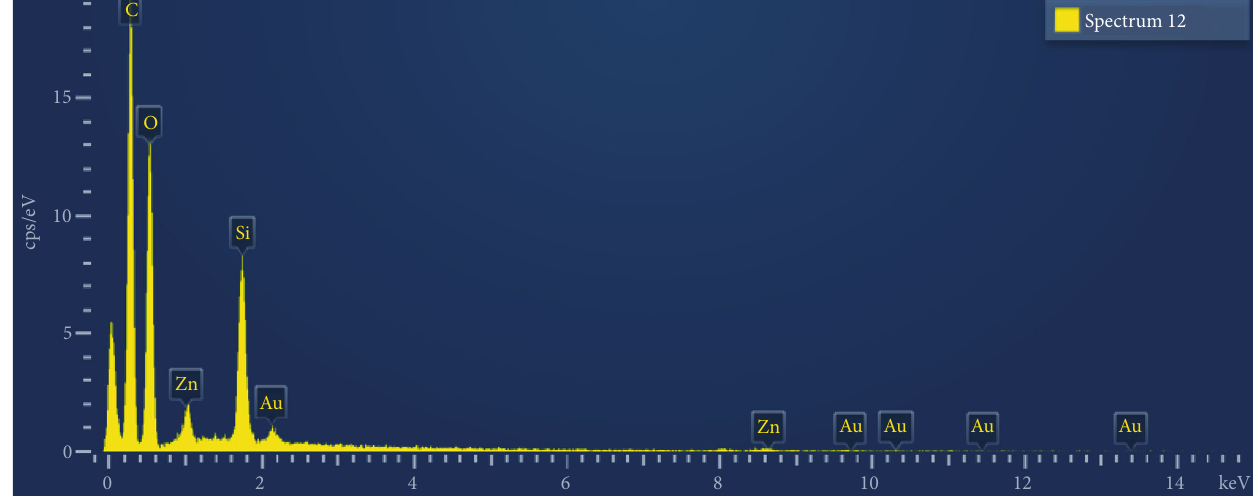
Figure 5: Typical EDX spectrum of PVDF-based NC FSs with 20 wt.% silica NFs.